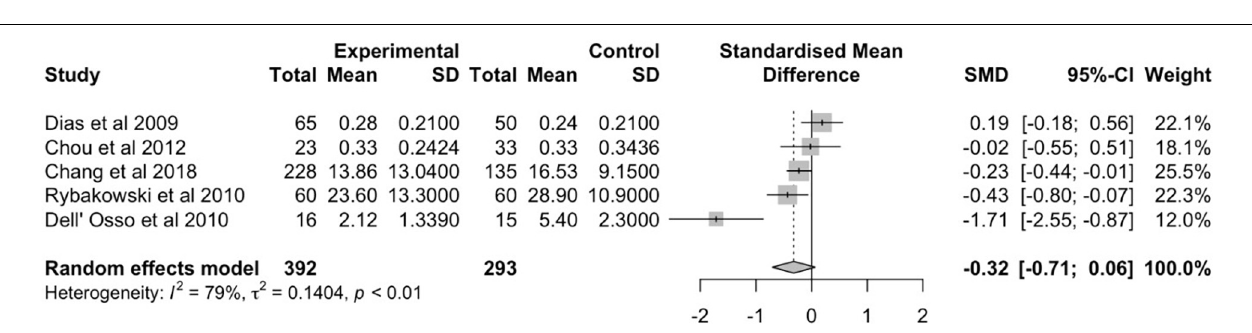
FIGURE 2 | Forest plot of standardized mean difference (SMD) in BDNF levels found in blood of patients with schizophrenia and healthy controls.